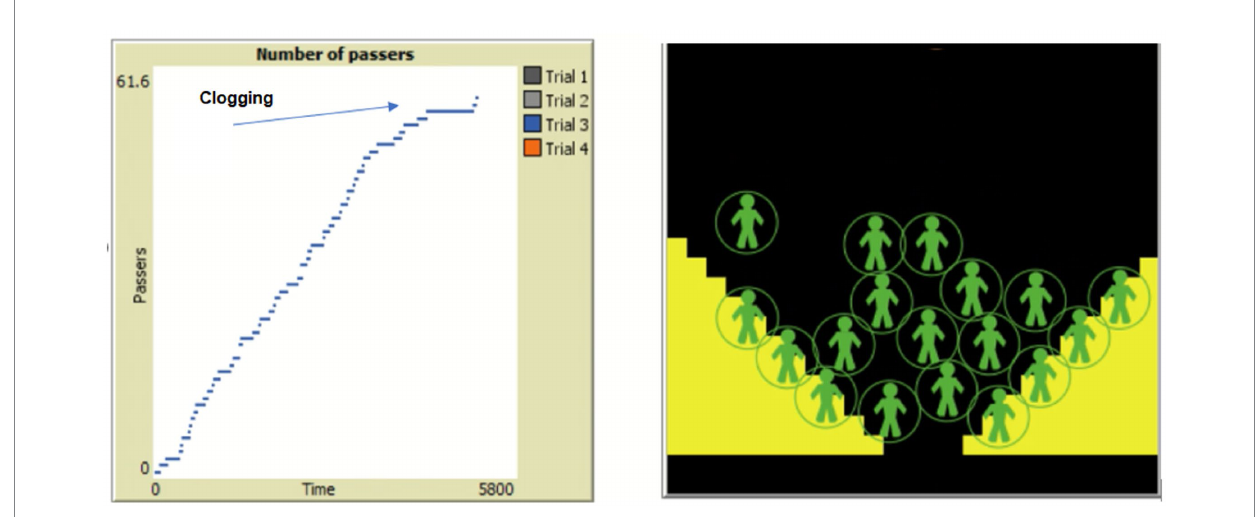
FIGURE 1 A bottleneck simulation in which a crowd moves towards a narrow passage at the bottom of the screen (right). The blue graph (left) shows the number of people that pass through the opening vs. time. The horizontal section marked by the arrow, represents temporary